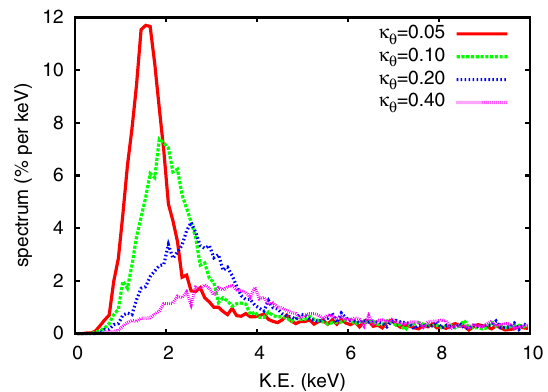
FIG. 8. Antiproton spectrum from the AD followed by de- grader foil and frictional cooling section for various values of (cid:10) (cid:9) .